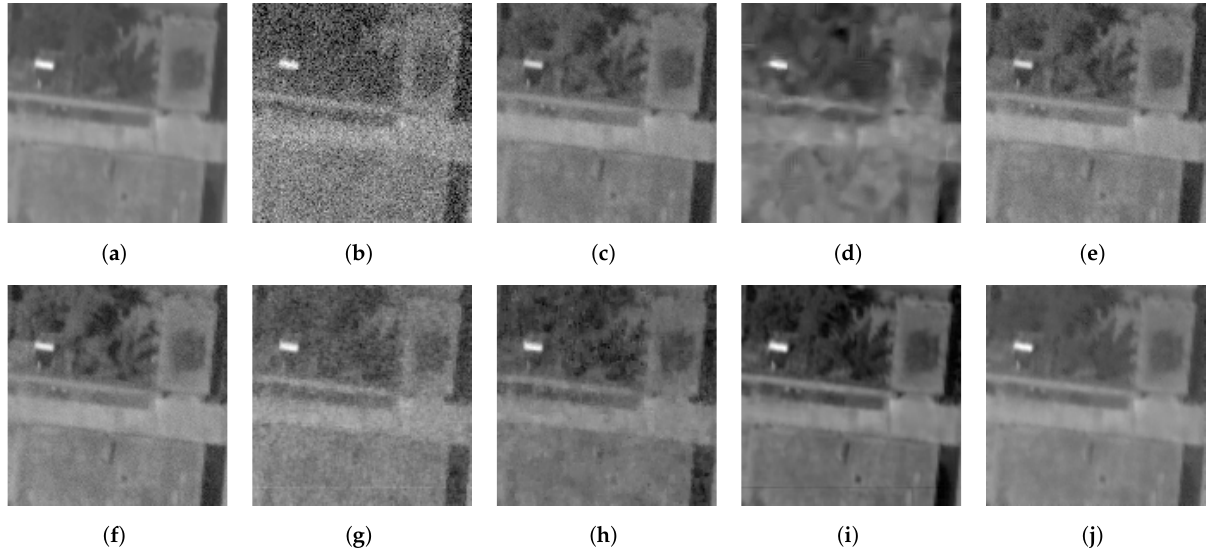
Figure 5. Case 1: The comparison of hyperspectral images (HSIs) denoising results with existing methods on the SFD dataset: ( a ) ground truth of band 3; ( b ) noisy image; ( c ) NNM; ( d ) BM4D;